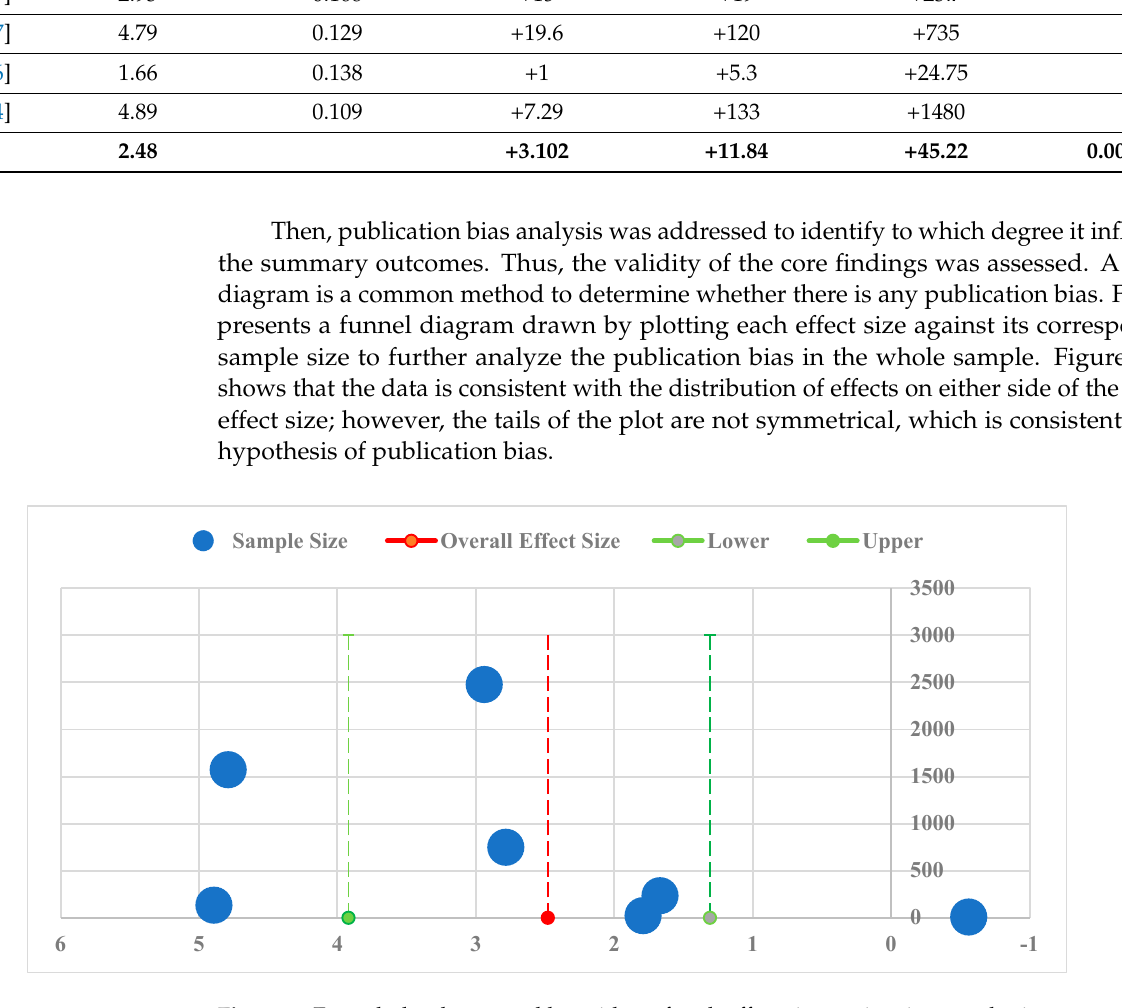
Figure 7. Funnel plot the natural logarithm of each effect size against its sample size.